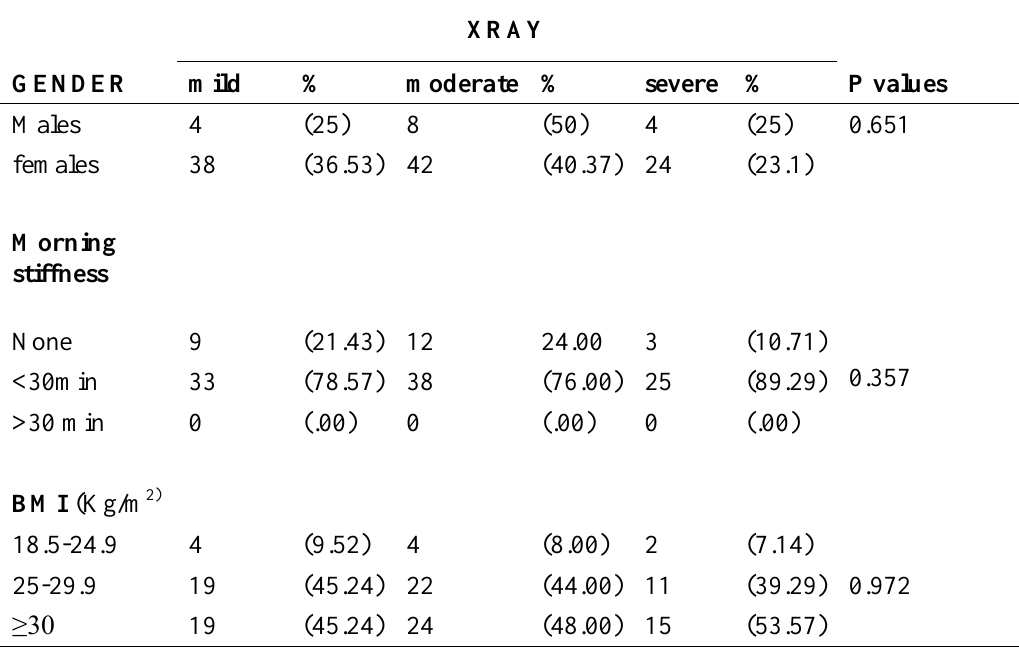
Table 3: Distribution of radiological findings in 120 knee osteoarthritis patients with their clinical features.